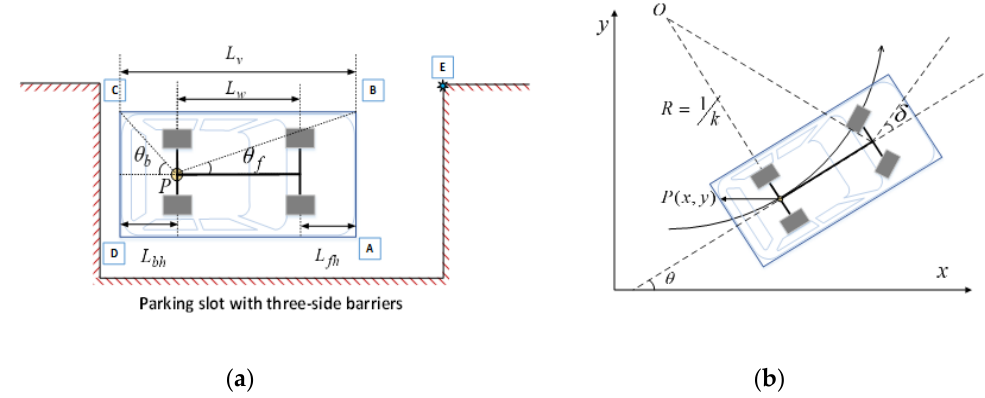
Figure 1. Simplified model of vehicle and parking slot ( a ); and vehicle kinematic model ( b ).